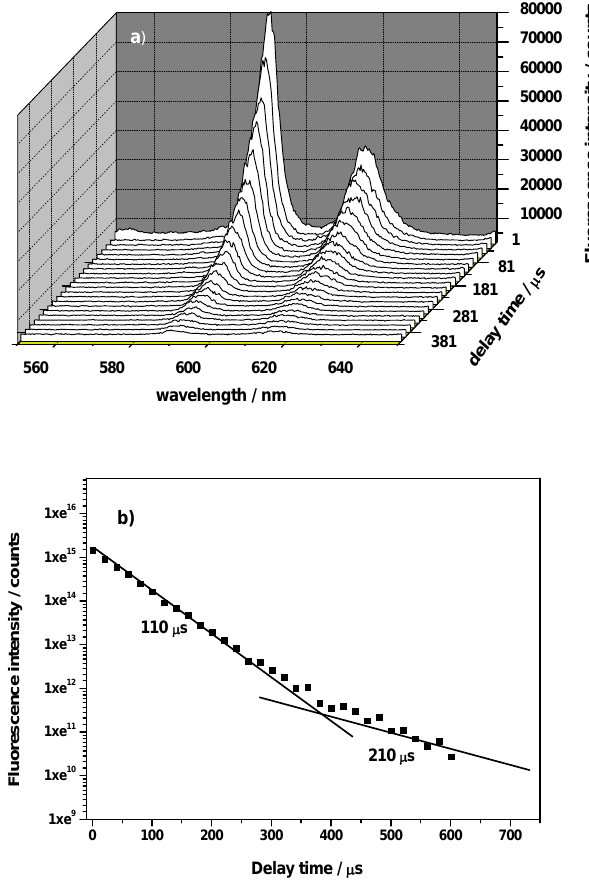
Figure 3. Three-dimensional spectra (a) and time dependent fluorescence spectra (b) of Eu(III) in alumina suspension. [Eu(III)] = 4.1  10 -6 mol/L, m/v = 0.44 g/L, T = 20 ºC, pH = 5.3 ± 0.1, I = 0.1 mol/L NaClO 4